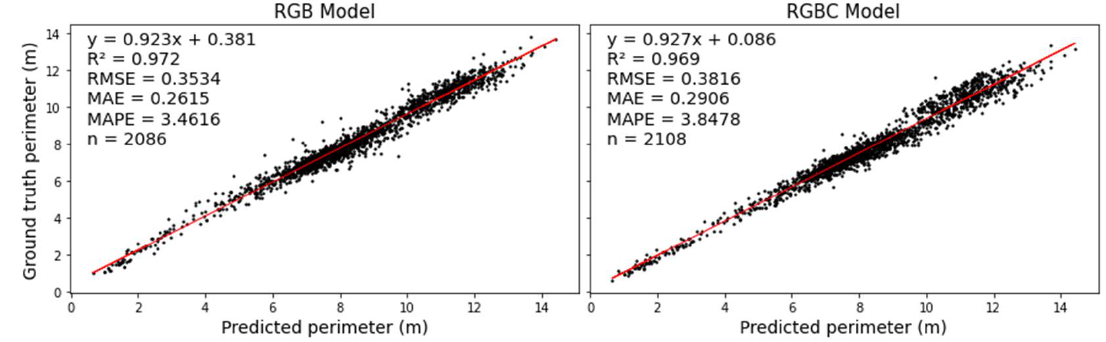
Figure 13. Linear regression results for crown diameter.